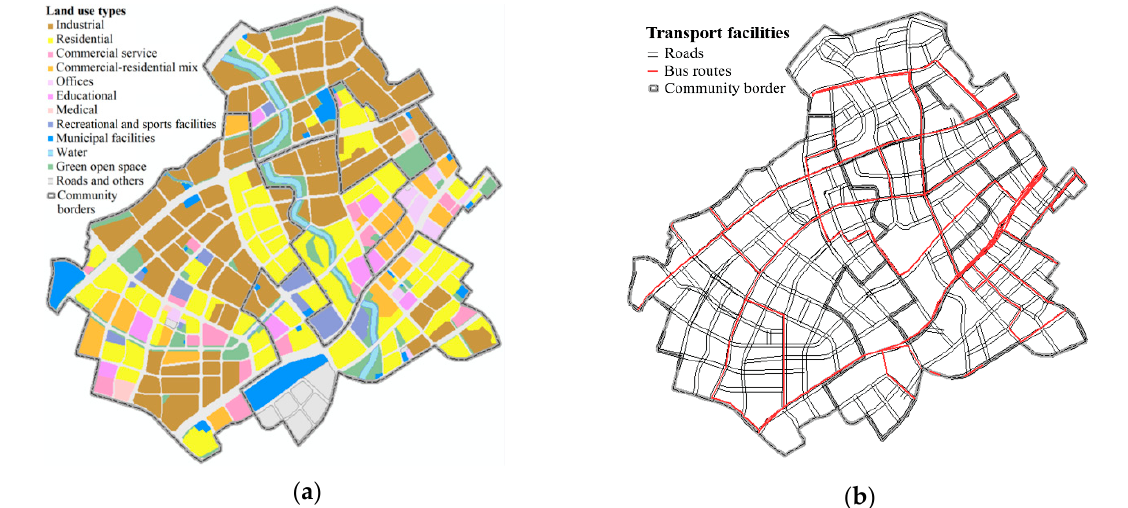
Figure 2. Land use ( a ) and transport facilities ( b ) in the study area.